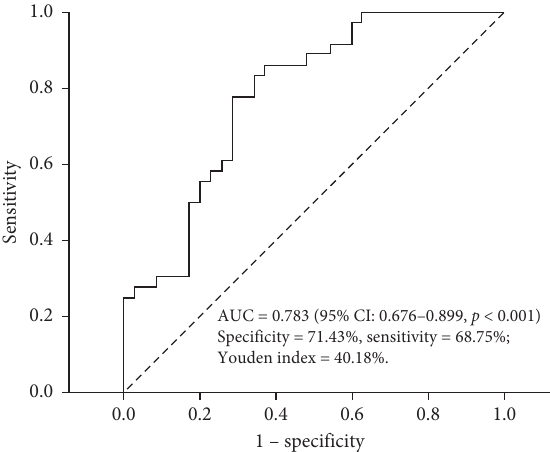
Figure 1: ROC of predictive model for NIV outcome.